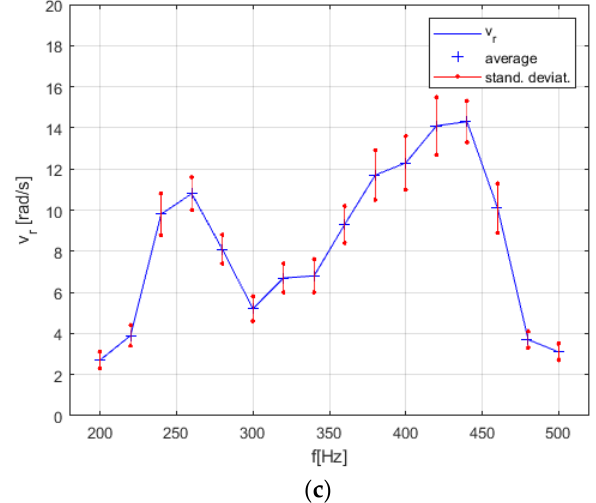
Figure 15. Measurements for the pot-like microfluidic rotational vibrational motor with rigidly attached disc to the rotating axis. ( a ) Vibration amplitudes a 1 and a 2 versus frequency f . ( b ) Phase shift α versus frequency f . ( c ) Rotational velocity 𝑣 𝑟 versus frequency f .